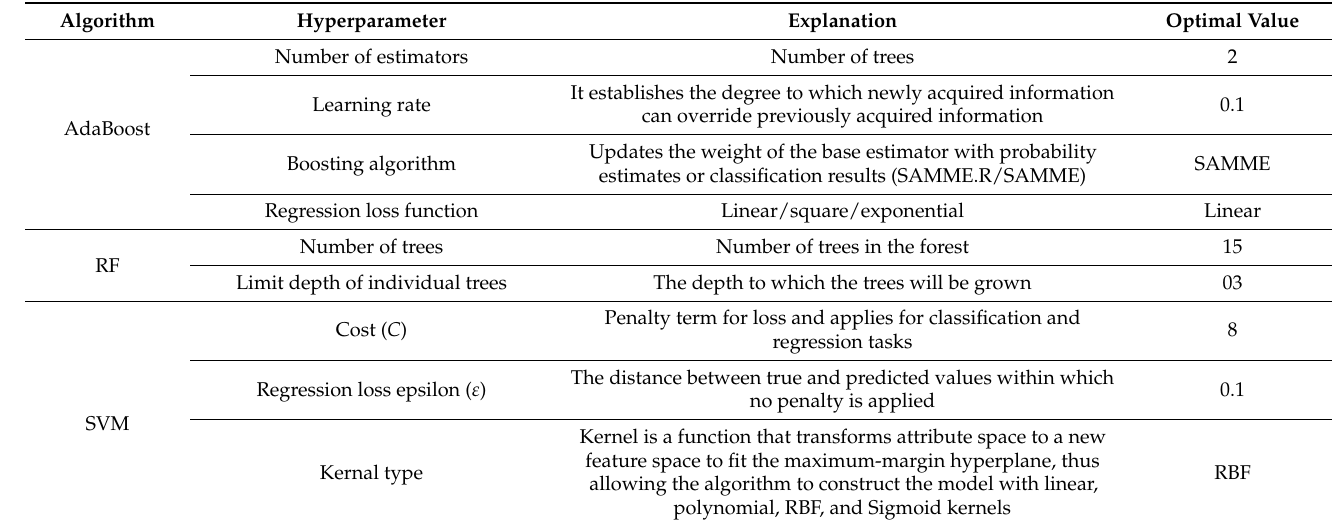
Table 3. Hyperparameter optimization